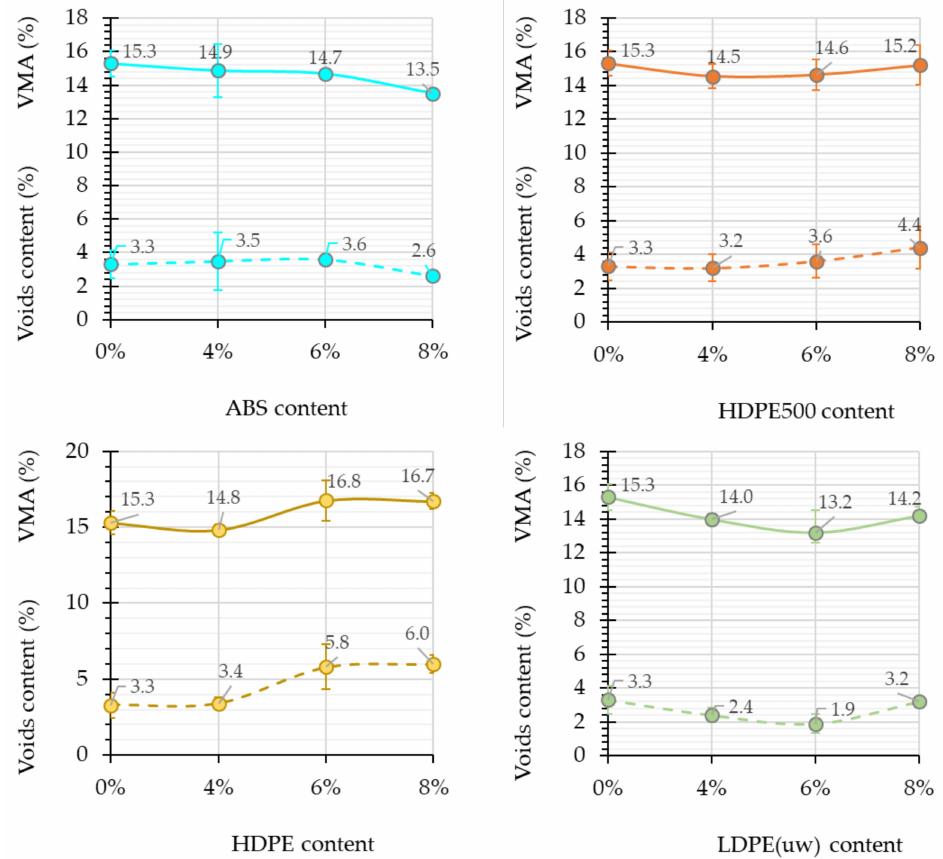
Figure 6. Variation of volumetric properties with the plastic waste